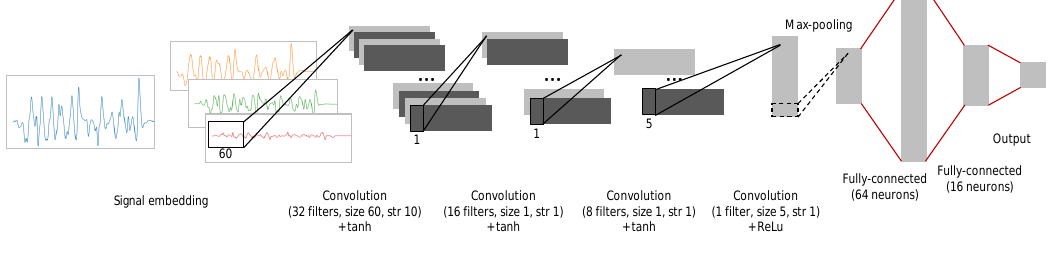
Figure 2. Architecture of the overall